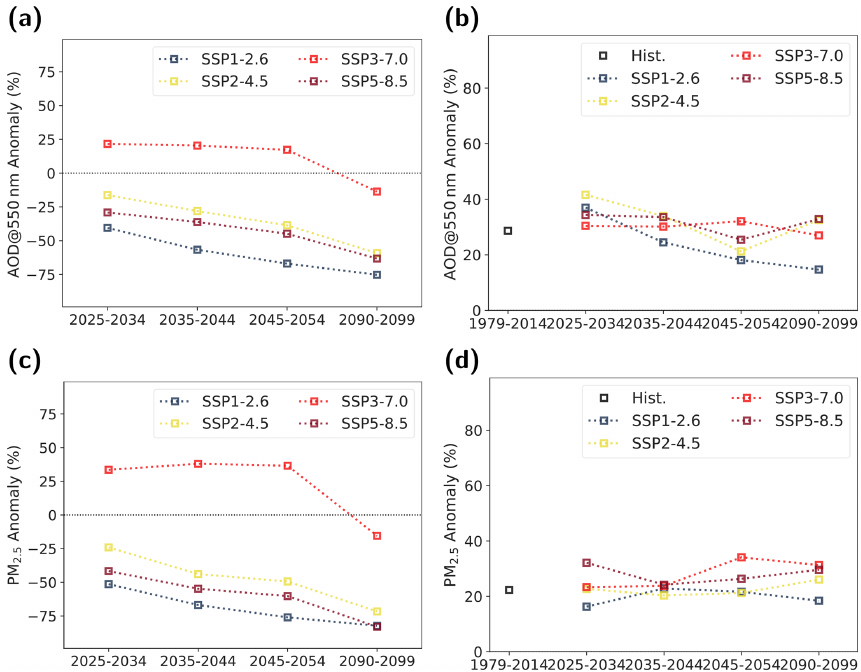
Figure 5. (a) AOD at 550nm anomalies during haze events (HWI > 1) compared to the present day, averaged over Beijing (37.5–42.5 ◦ N, 114–119 ◦ E). (b) AOD at 550nm anomalies during haze events (HWI > 1) compared to contemporary non-haze days (HWI ≤ 0) over Beijing. (c) PM 2 . 5 anomalies (HWI > 1) compared to the present day, averaged over Beijing. (d) PM 2 . 5 anomalies compared to contemporary non-haze days (HWI ≤ 0) over Beijing. Units: